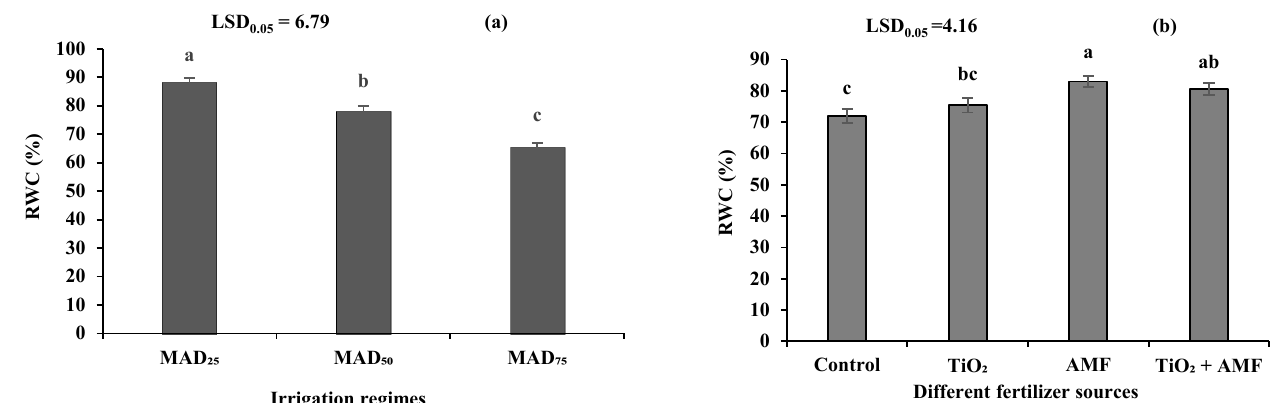
Figure 4. The relative water content (RWC) of sage in different irrigation regimes ( a ) and fertilizer sources ( b ). MAD 25 , MAD 50 , and MAD 75 indicating non-stressed, moderate, and severe drought stress, respectively. AMF: arbuscular mycorrhizal fungi; TiO 2 : titanium dioxide nanoparticle. Different letters indicate significant differences at the 5% level according to LSD test.